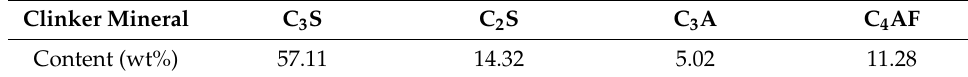
Table 2. The mineralogical phase composition of Portland cement.